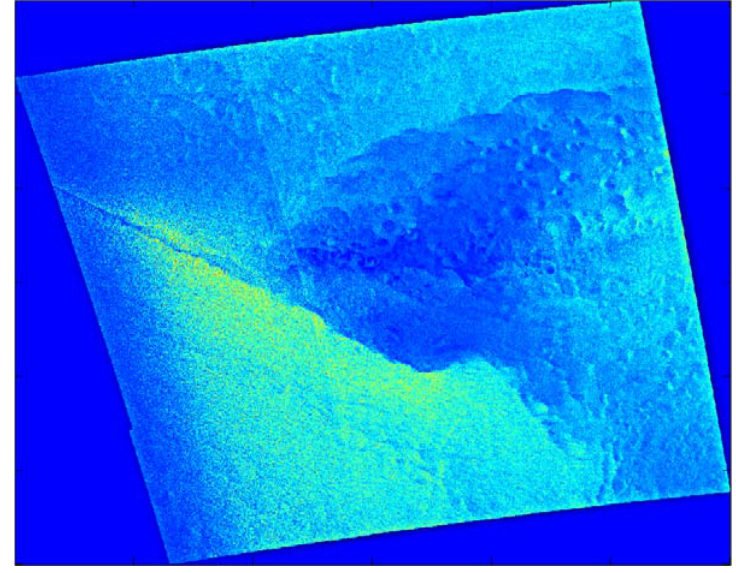
Figure 4. Low-pass Gaussian filtered SDWS image for the case study, 0533 UTC on December 9, 2007. Brighter shades indicate larger wind speeds with green being the largest.